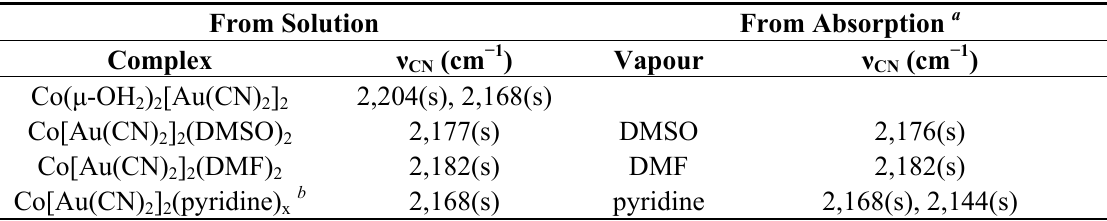
Table 1. Cyanide vibration frequencies ( ν (M = Co, Ni) complexes synthesized from solution and from vapour